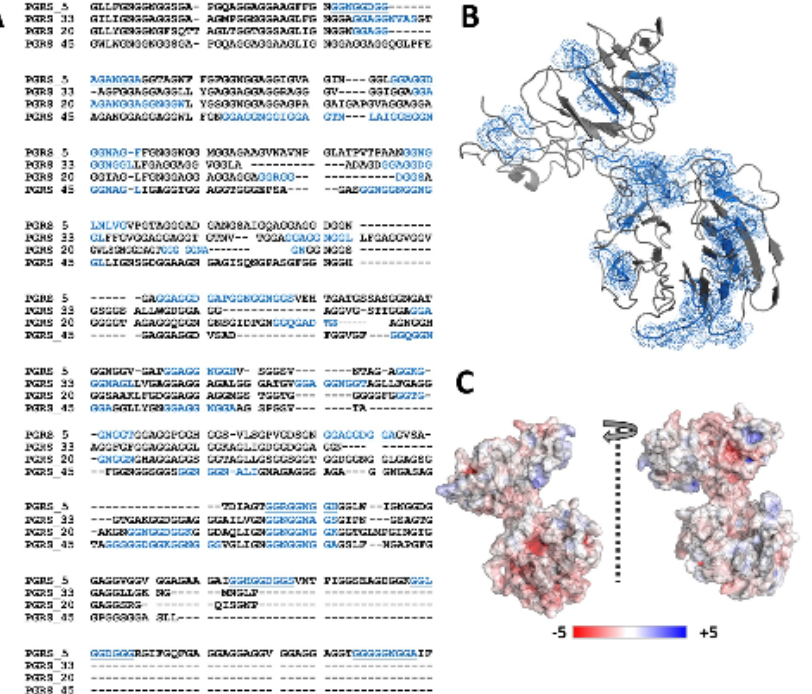
Figure 1. Sequence and structural features of Rv0297PGRS. ( A ) Sequence alignment of PGRS domains from various PE_PGRS proteins of M.tb . PGRS_5 (Rv0297PGRS) is aligned with a known calcium-binding protein PGRS_33 (Rv1818cPGRS) and other PGRS proteins containing putative calcium-binding motifs; PGRS_20 (Rv1068c) & PGRS_45 (Rv2615cPGRS) of M.tb. Highlighted blue are putative calcium-binding regions. ( B ) Modeled structure of Rv0297PGRS monomer showing spatial distribution of calcium-binding motifs (Blue). ( C ) Surface electrostatic potential of Rv0297PGRS calculated by APBS. Positively charged regions are colored in blue and negatively charged regions in